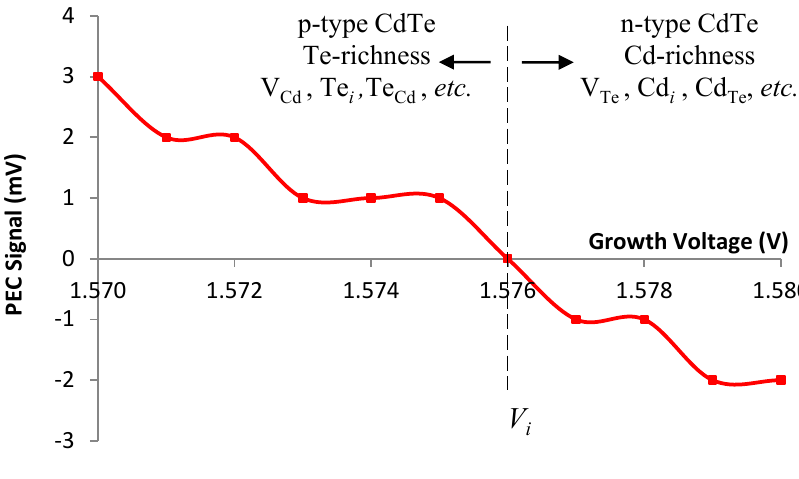
Figure 1. Photoelectrochemical (PEC) signal as a function of electrodeposition voltage for ED-CdTe layers grown in the vicinity of the stoichiometry point ( V transition from p-type to n-type, due to Te-richness and Cd-richness. Most possible native defects within CdTe layers are also given in the two regions